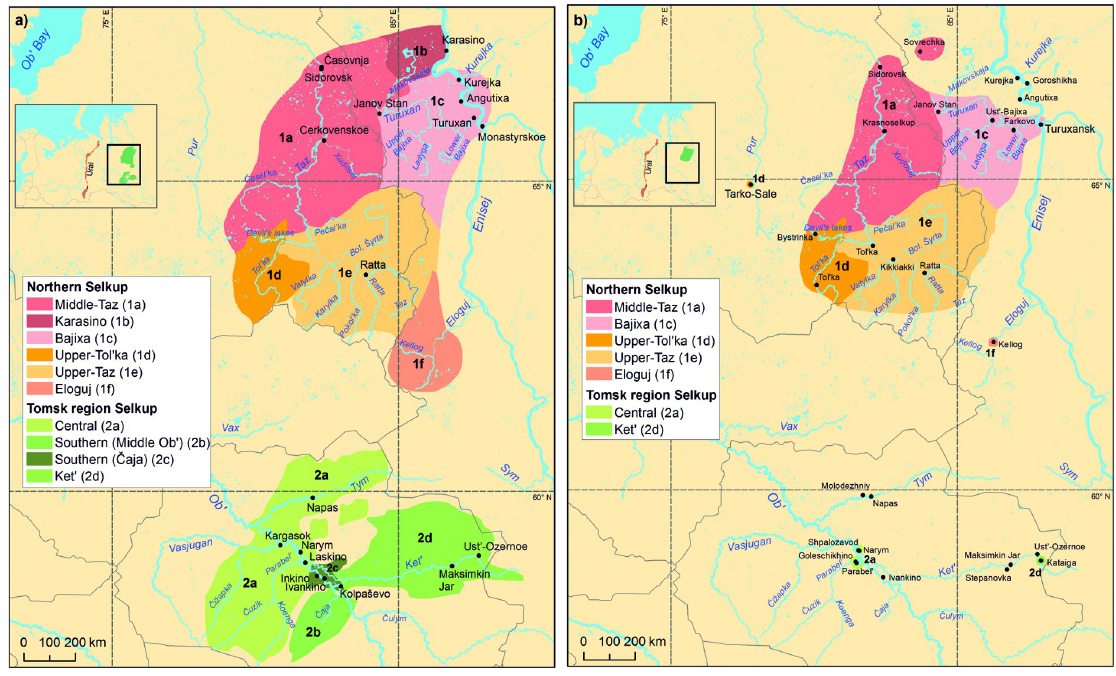
Fig 5. Traditional (a) and current (b) distribution of Selkup. A comparison of the maps demonstrates the changes in language and dialectal distribution over time. Original sources for traditional distribution are Gru¨nthal & Salminen [33], Tuchkova et al. [60] and for